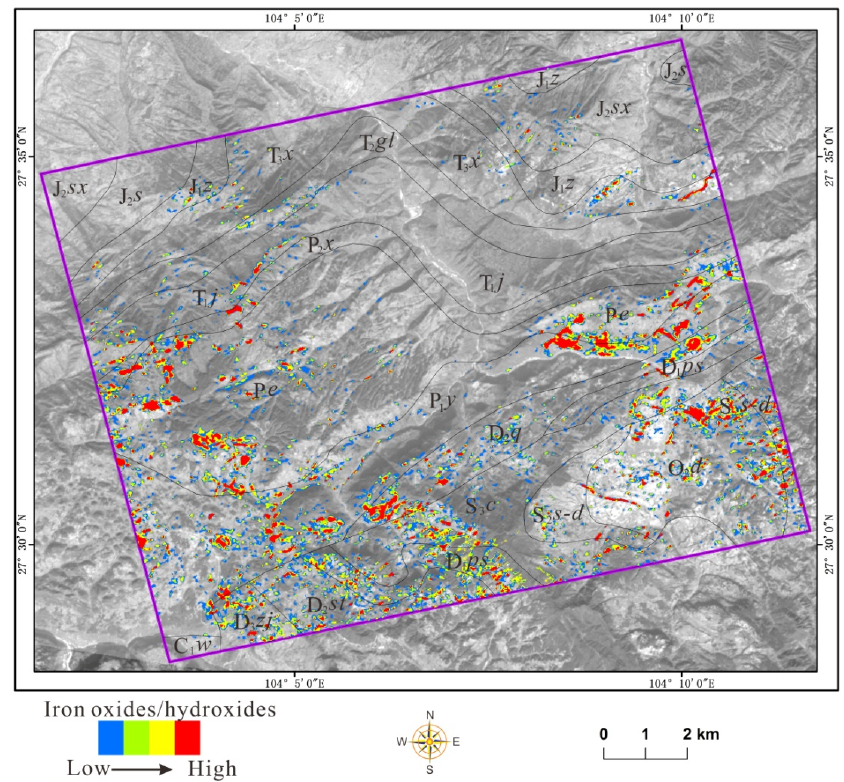
Figure 3. Iron oxide/hydroxide minerals mapped with ASTER data using the SPCA method.